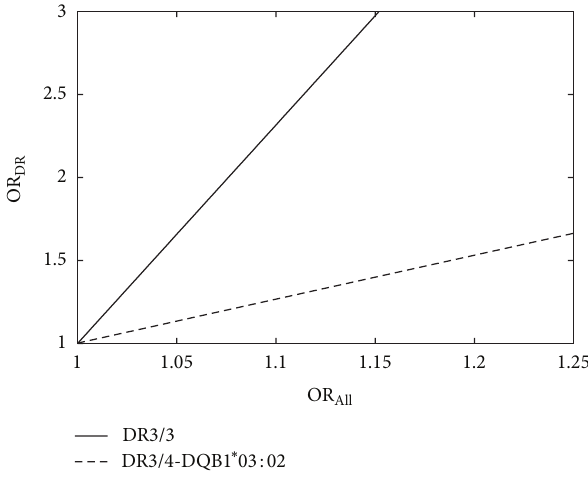
Figure 5: Calculated improvement in odds ratio (OR) when stratifying by HLA-DR-DQ genotype (OR DR ) versus analyzing all T1D patients (OR All ) for detection of a putative risk TCR allele. Shown are data for homozygous HLA-DR3/3 and the high-risk DR3/4-DQB1 ∗ 03:02